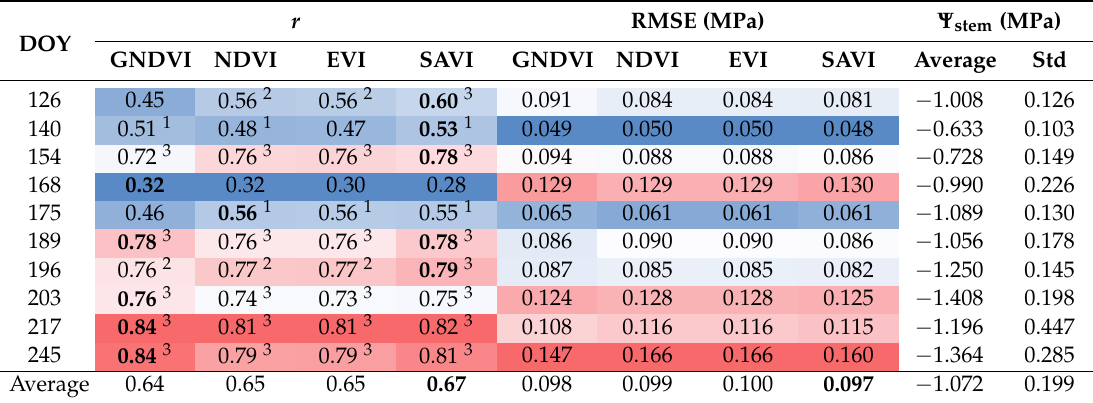
Table 2. Statistics of the per-week multivariable linear models ( MB-Mult ) using the four Planet-derived VIs (GNDVI, NDVI, EVI and SAVI). The model with the highest Pearson’s- r and lowest RMSE (in MPa) scores is indicated in bold for each date. Low/high r and RMSE scores along the season are denoted with blue/red colors per